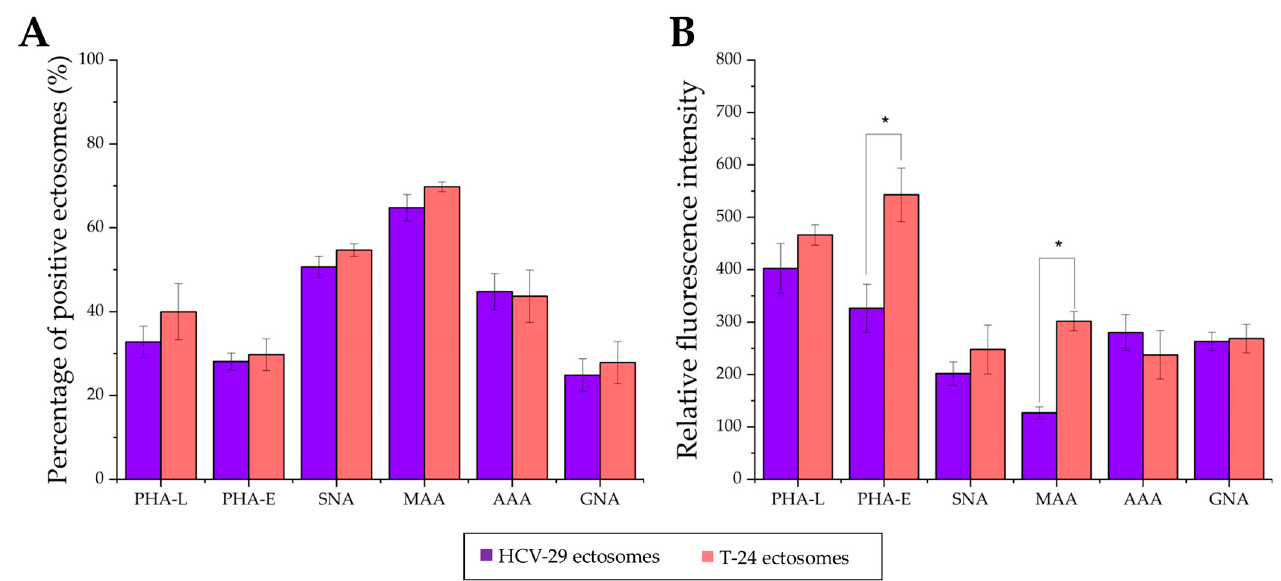
Y axis shows log fluorescence intensity measured on 488Gn laser.